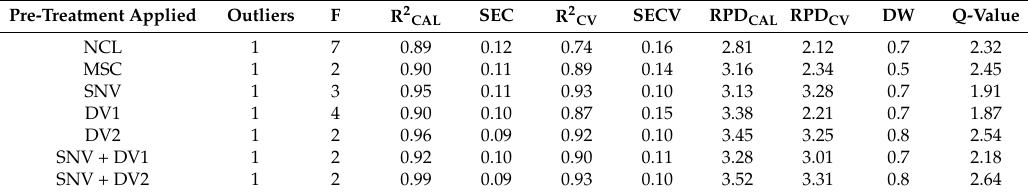
Table 2. The optimal PLS model prediction results for TOC and the corresponding statistical parameters of the various single and combined pretreatments for the GSS set. (NCL = normalization by closure; MSC = full-multiplicative scatter correction, SNV = standard normal variate; DV1 = 1st derivative; DV2 = 2nd derivative).